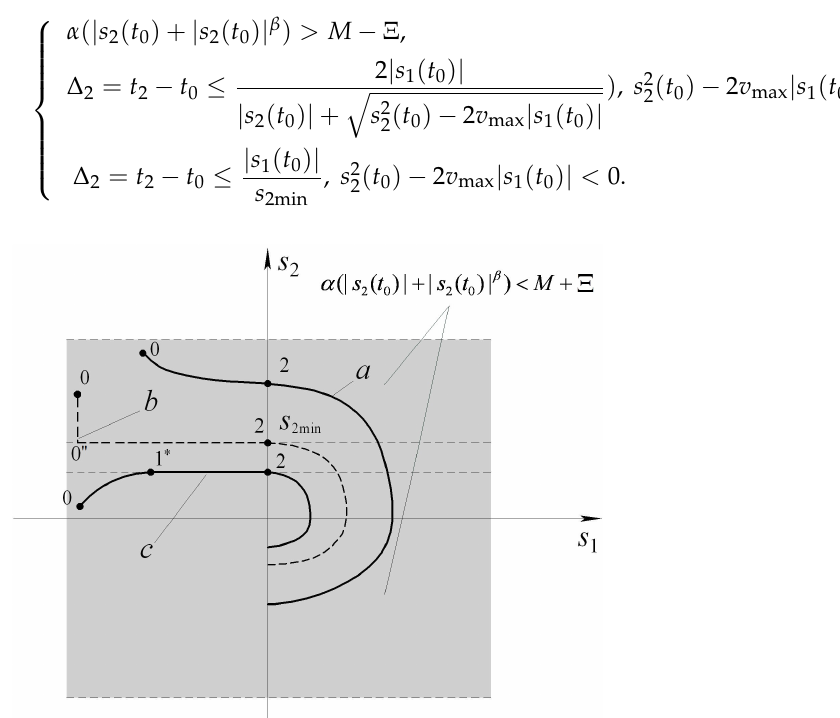
Figure 4. Phase portraits under initial conditions from the second and fourth quadrants (Situation